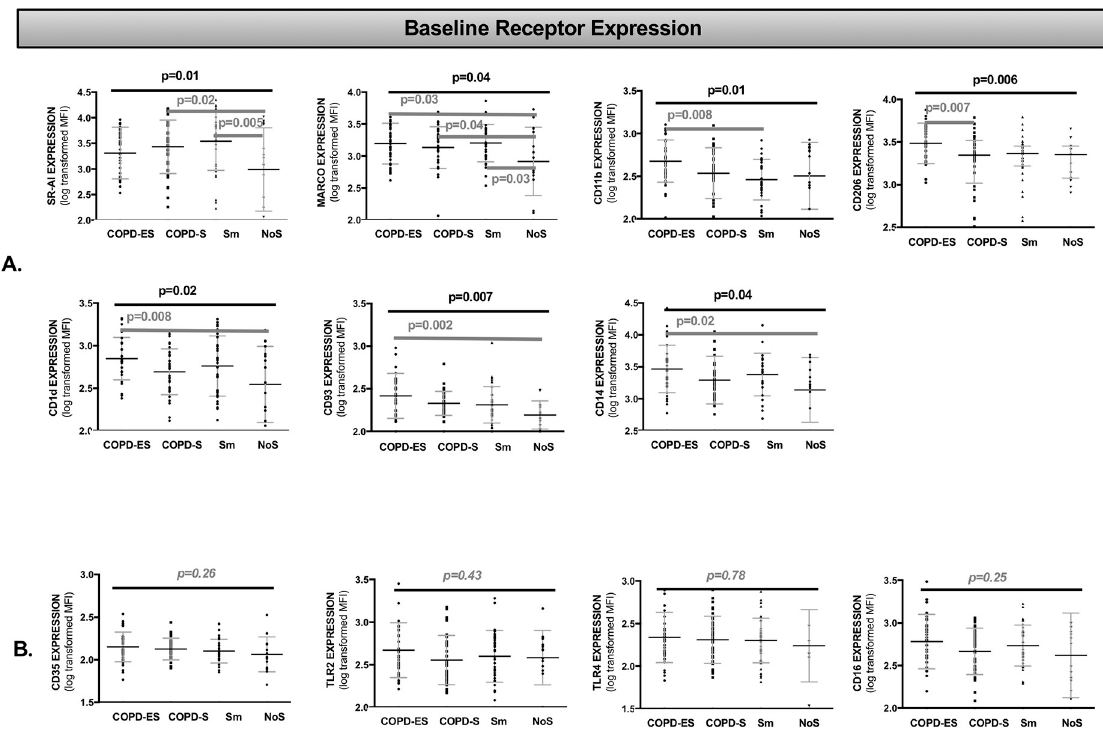
Fig 1. Cell surface bacterial recognition receptor expression at baseline was greater on MDMs from subjects with COPD and healthy smokers as compared to non-smokers. Analysis by one-way ANOVA for receptor MFI (mean fluorescence intensity), representative of cell surface receptor density, presented as an aligned dot-plot with thin black bar at the mean, flanking short grey bars delineating the SD. Thick black horizontal bars above the entire graph mark the ANOVA results of statistical significance. Thick dark grey horizontal bars start and end at the comparisons of statistical significance identified in multiple comparison analysis (A). The bottom row (B) presents the receptors that did not have significant differences in cell surface expression between groups at baseline. Holm-Sidak correction was performed for multiple comparisons. COPD-ES = COPD ex-smoker, COPD-S = COPD current smoker, Sm = smoker without COPD, NoS = non-smoker healthy control, SR-AI = Scavenger receptor A-I, MARCO = Macrophage receptor with collagenous structure, TLR = Toll like receptor. S2 Fig demonstrates the Fig 1A differences in baseline receptor expression in heat map